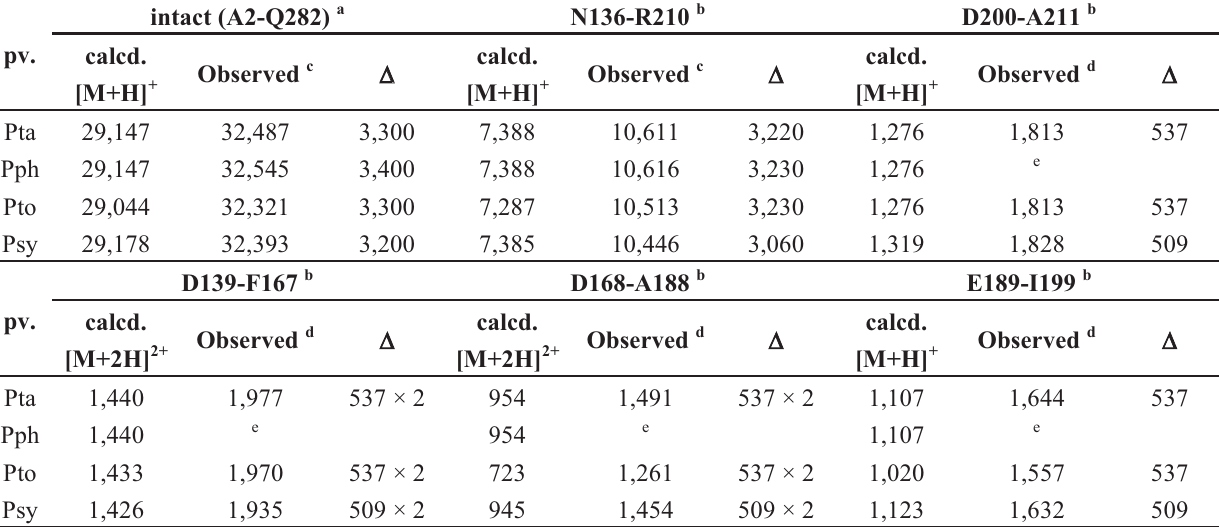
Table 2. m/z values of intact flagellin and each peptide fragment